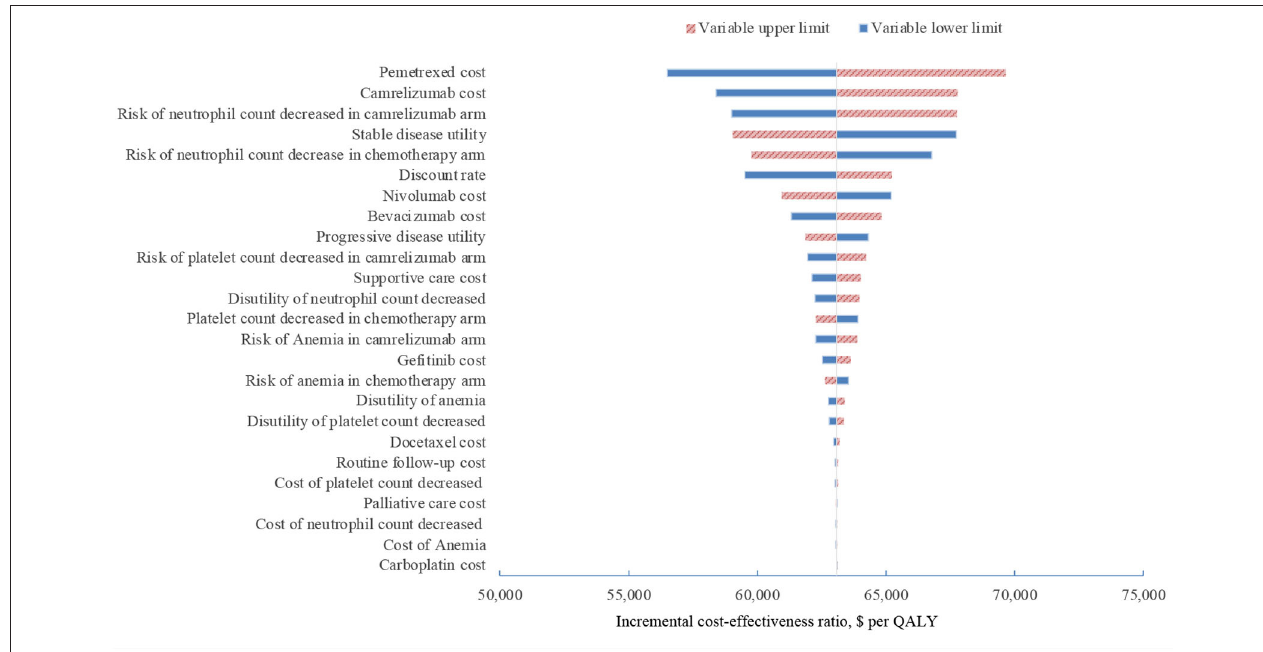
FIGURE 1 | Deterministic sensitivity analysis for the base case analysis. QALY, quality-adjusted